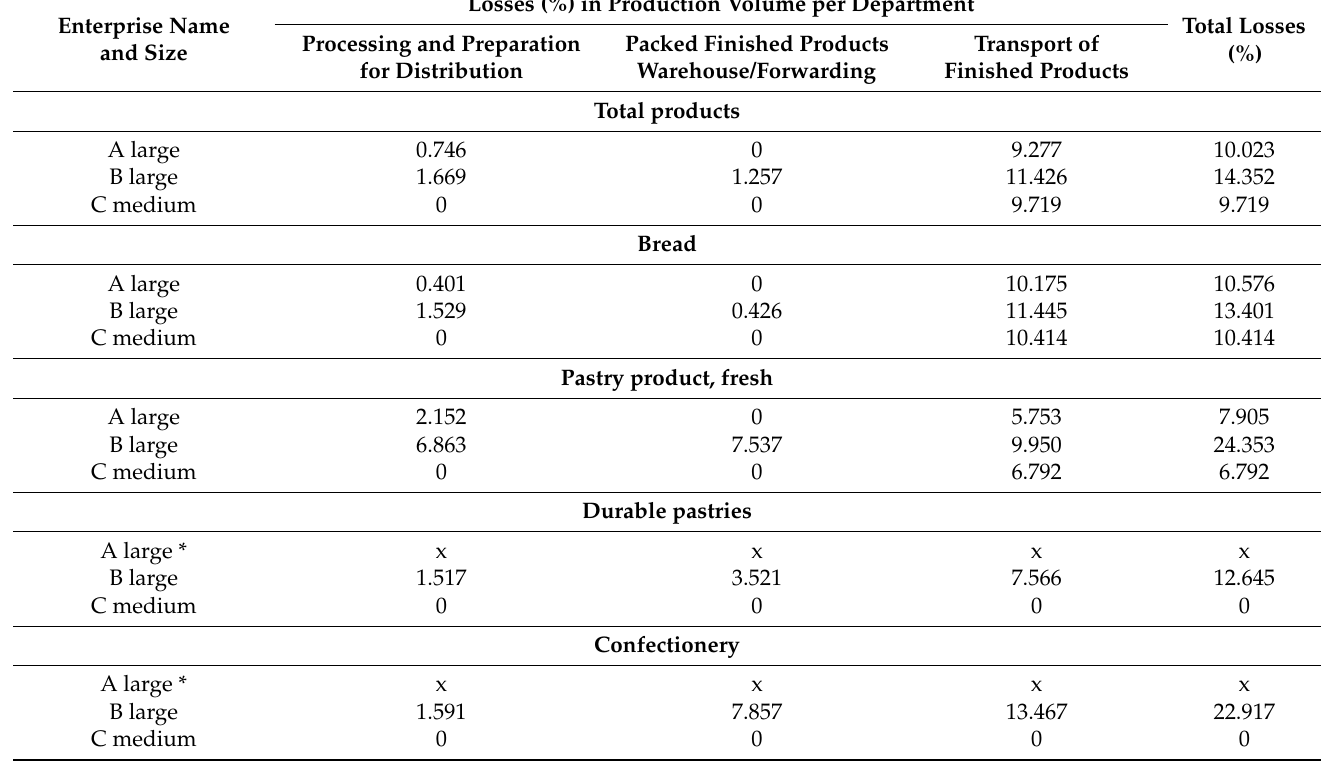
Table 3. The food losses in total and in individual departments of bakeries that monitored mass balance, as a % of production